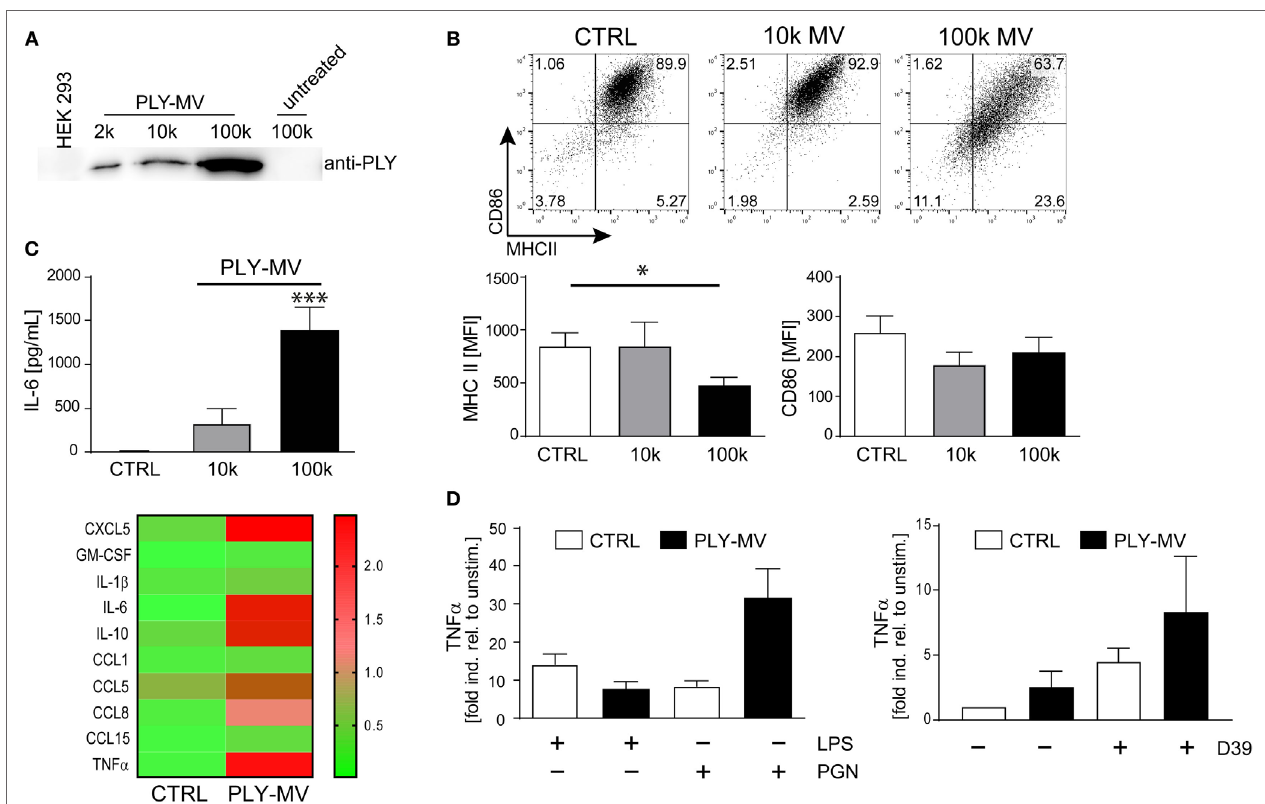
FigUre 1 | Pneumolysin (PLY)-induced microvesicles generate phenotypic changes in human macrophages in vitro . PLY-pores shed on microvesicles (PLY-MV) were generated by HEK-293 cells by stimulation with 2 µg/ml purified PLY for 30 min. This protocol, using a sub-lytic PLY concentration, ensures efficient membrane repair induction in HEK-293 cells without causing substantial cell death (7). (a) Isolation of PLY-MV. PLY-MV were isolated by differential centrifugation from cell culture supernatants and fractions (2 k, 2,000 × g pellet; 10 k, 10,000 × g pellet; 100 k, 100,000 × g pellet) were analyzed by Western blotting with a monoclonal antibody against PLY. One representative blot of three independent experiments is shown. (B) Stimulation of macrophages with PLY-MV. Day 7 M-CSF induced human macrophages were stimulated with PLY-microvesicles. FACS analysis after 48 h stimulation showed a marked downregulation of MHCII and CD86 in CD14 + gated macrophages treated with PLY-MV (100 k MV) as compared to untreated controls (CTRL) or 10 k MV-treated cells. A representative FACS blot is shown. Mean fluorescence intensity (MFI) of MHCII and CD86 of CD14 + gated cells were subjected to statistical analysis (100 k MV; mean ± SD; n = 5; * p < 0.05; unpaired t -test; two-tailed). (c) Cytokine profile of PLY-MV induced macrophages. Macrophages were stimulated as in (a) and IL-6 production was determined after 48 h from culture supernatants using Bio-Plex (BioRad, Mean ± SD; n = 5; *** p < 0.001; unpaired t -test; two-tailed) or for global cytokine analysis Abcam cytokine arrays with pooled supernatants from three independent experiments were performed (heat-map; lower panel). Densitometric analysis were accomplished using the ImageJ protein analyser macro [written by G. Carpentier, 2010; http://rsb.info.nih.gov/ij/macros/toolsets/Protein%20Array%20Analyzer.txt]. Only cytokines with at least threefold difference between CTRL and 100 k PLY-MV were evaluated. (D) Re-stimulation of PLY-MV induced macrophages. Re-stimulation was performed with 100 ng/ml LPS, 1 µg/ml peptidoglycan, or supernatant from Streptococcus pneumoniae strain D39 ( D39 ) for 6 h. RNA was isolated at time points 0 and 6 h. RT-PCR analysis was performed using primers for TNF α and SYBR green RT-PCR kit. Glyceraldehyde 3-phosphate dehydrogenase (GAPDH) served as a reference gene (mean ± SD n =